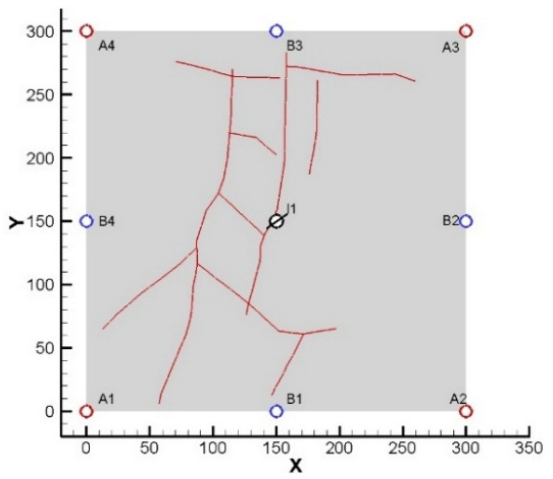
Figure 9. Geological structure of coal reservoir.